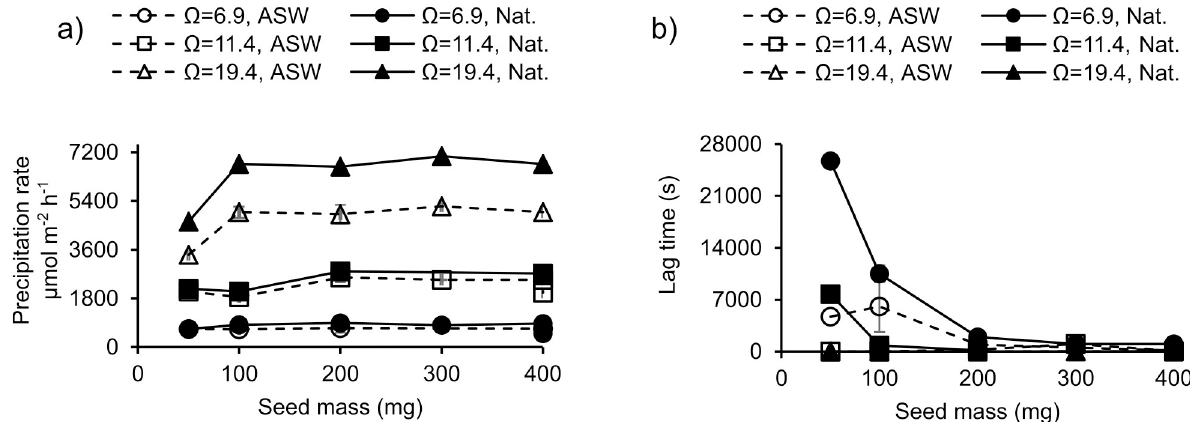
Fig 6. Estimated a) aragonite precipitation rate and b) lag period at start of precipitation in experiments comparing O , starting seed mass and different waters. ASW = artificial seawater. Nat. = natural seawater. Error bars indicate 1 σ of duplicate precipitations. The reproducibility of estimated precipitation rates from duplicate experiments was typically 6% and was always < 10%. (Reproducibility of lag periods was always better than